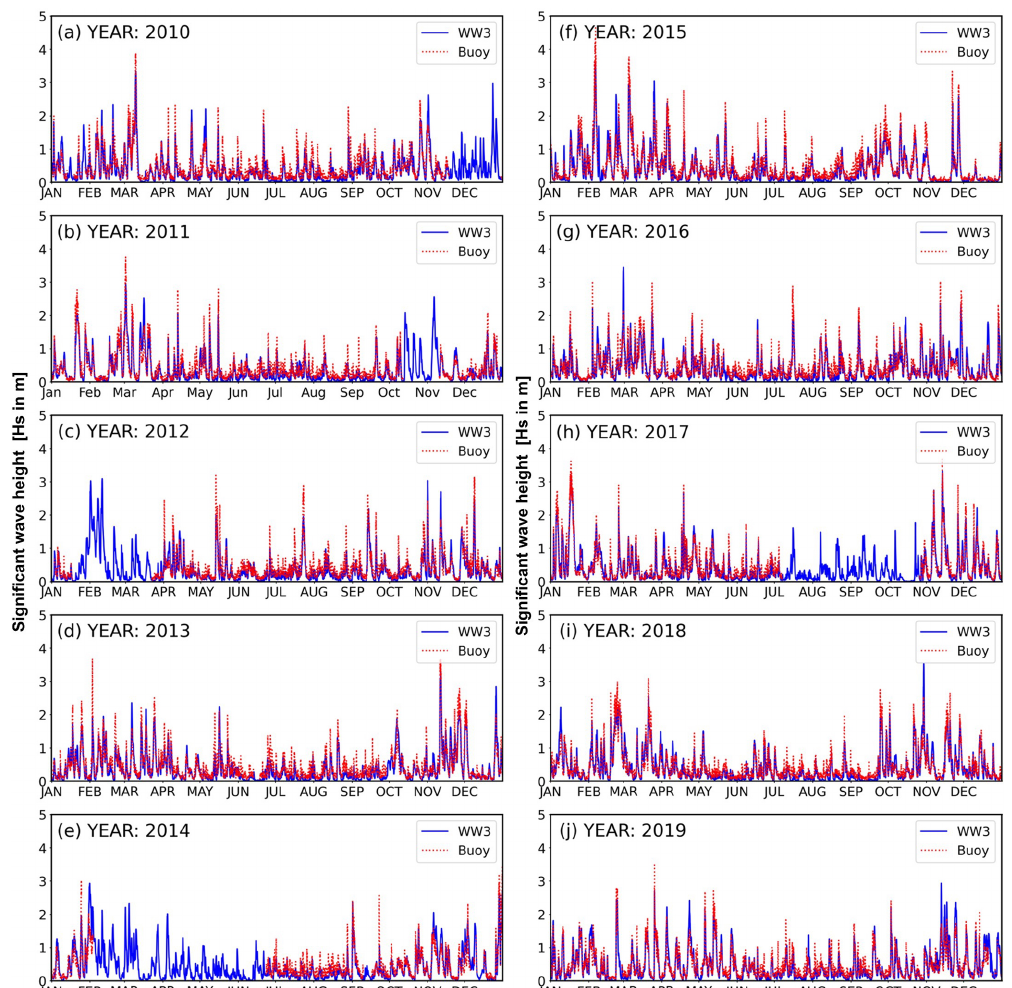
Figure 2. Time series plot of (a–j) significant wave height (in metres, indicated by solid blue lines) and observations (dotted red lines) for 2010–2019 at station 6 (Cesenatico; see Fig. 1c for